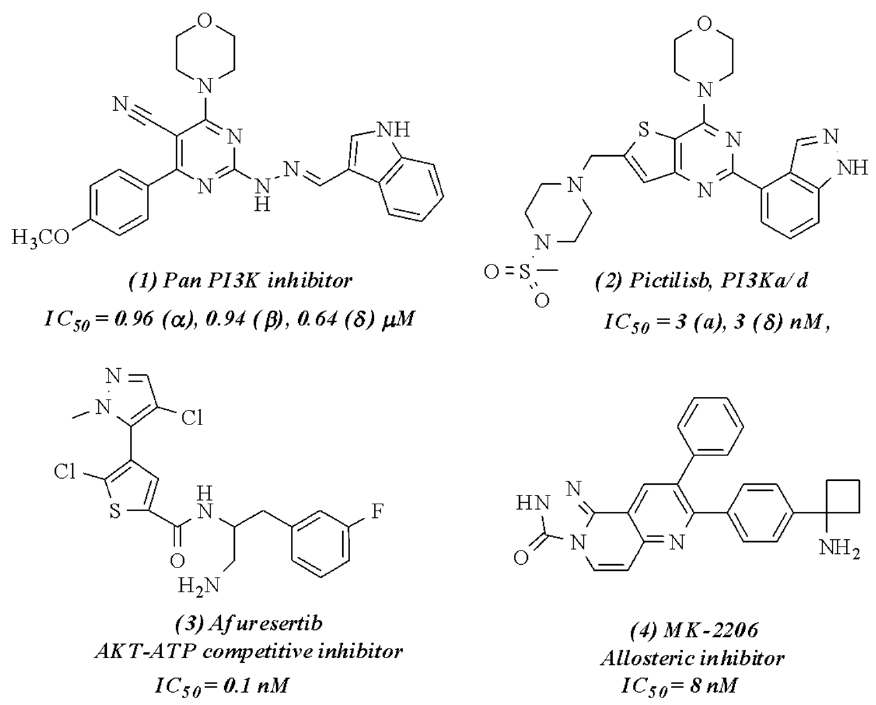
Figure 1. Reported PI3K and Akt inhibitors. Structures 1 and 2 are adapted from [17], 3 from [18], and 4 from [19].